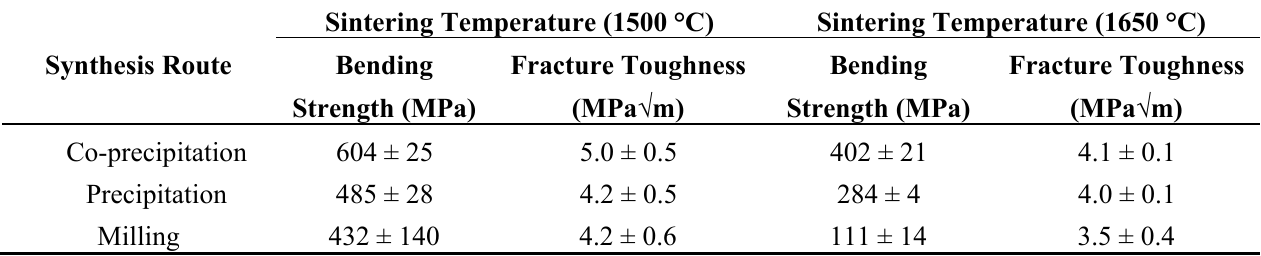
Table 3. Mechanical properties of Al 2 O 3 /YAG powders prepared by (i) co-precipitation; (ii) precipitation of Al(OH) 3 in a YAG slurry; (iii) traditional milling [139].